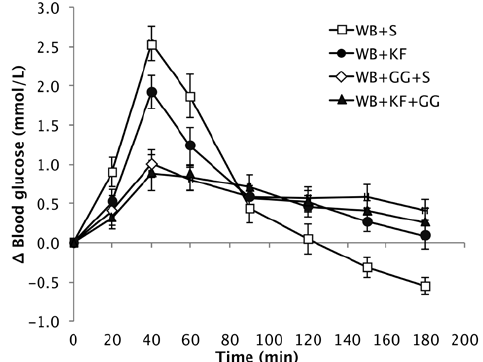
Figure 4. Increase over baseline in blood glucose concentration induced by the meals wheat biscuit (WB)+sugars (S) (WB+S), WB+kiwifruit (WB+KF), WB+guar gum+sugars (WB+GG+S), and WB+KF+GG (Means ± sem). Nutrients 2017 , 9 , 1195